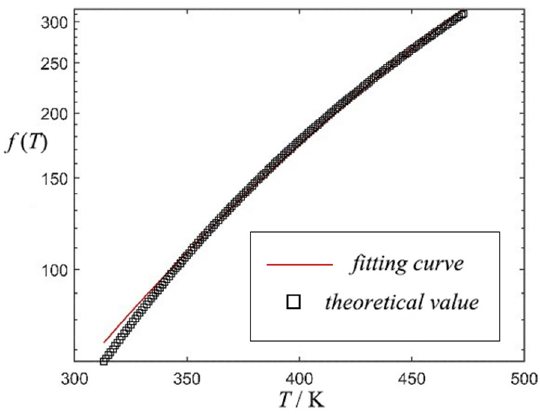
Figure 2. Fitting curve in the temperature range of 273 K–453 K.